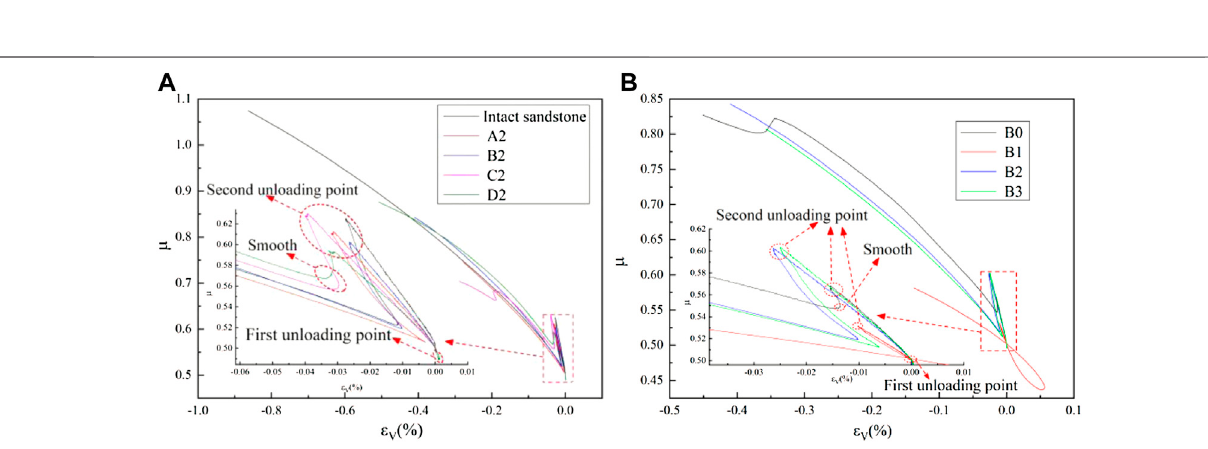
Frontiers in Earth Science |